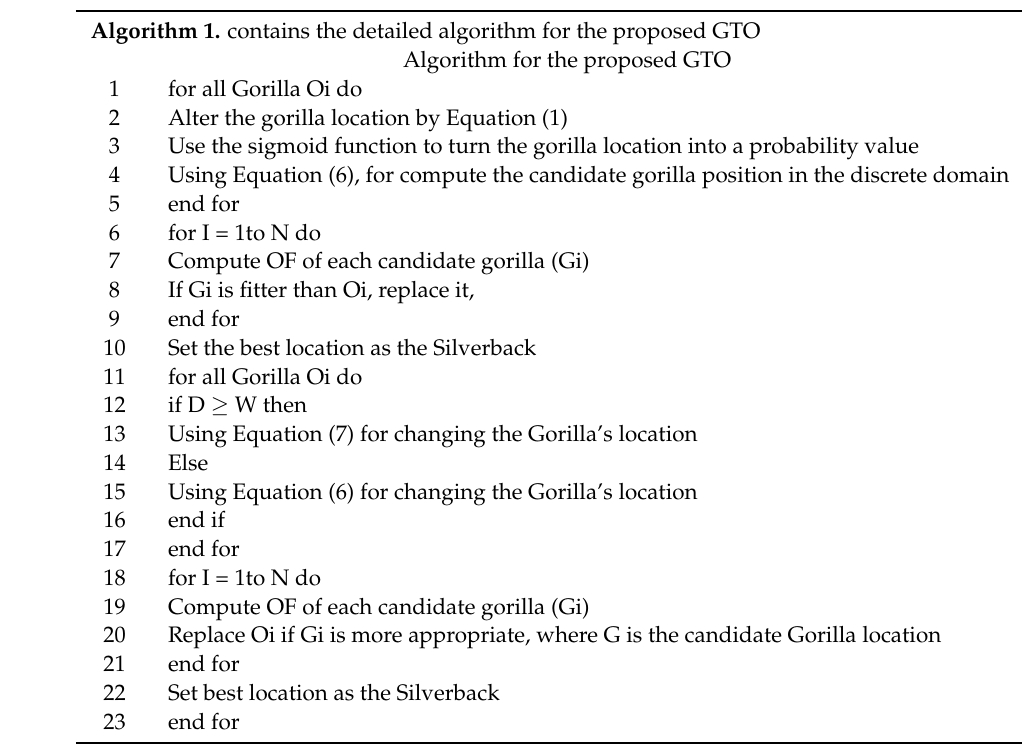
Algorithm 1. contains the detailed algorithm for the proposed GTO Algorithm for the proposed